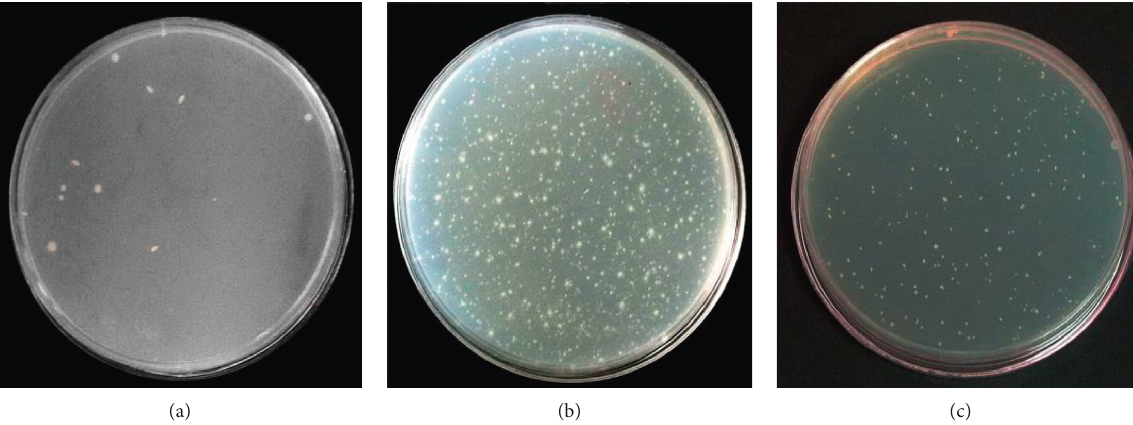
Figure 2: The revertants colonies in the negative test (a), positive test (b), and 7 mg/ml concentration of HBV